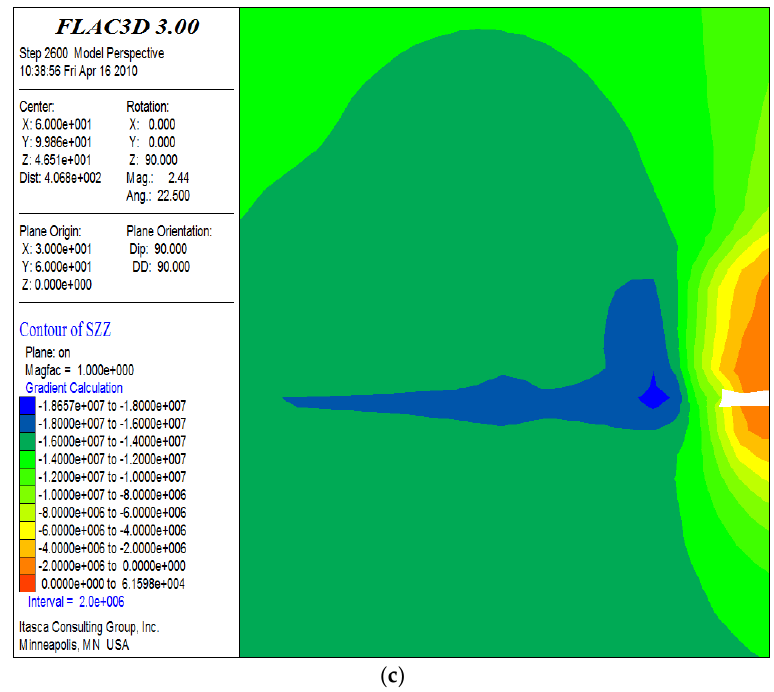
Figure 12. Simulation of stress distribution under three different conditions: ( a ) Borehole length 40 m, diameter 50 mm; ( b ) Borehole length 50 m, diameter 55 mm; ( c ) Borehole length 60 m, diameter 60 mm.